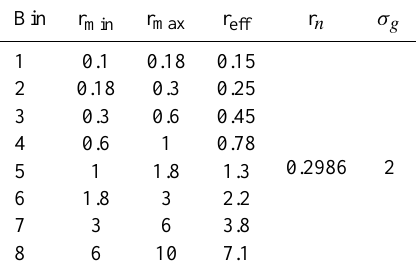
Table 1. The 8 transport size bins used by the SKIRON/Dust model. r min and r max are the minimum and maximum radius of each bin, r n the mass median diameter, r eff the effective radius and σ g the standard deviation of the lognormal